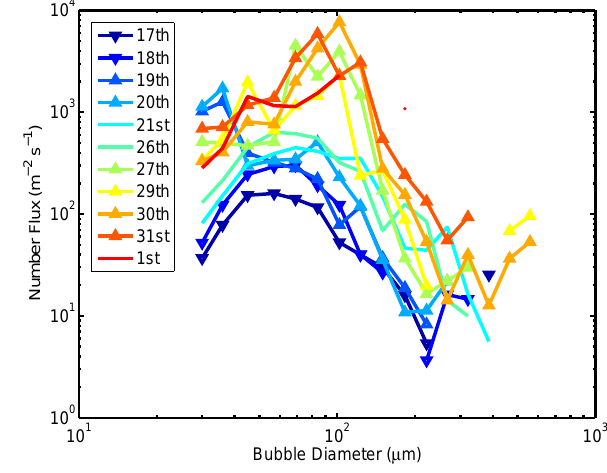
Fig. 12. The estimated total number flux of bubbles to the surface; symbols and colours are as in Fig. 9. Fig. 13. The mean size resolved bubble number fluxes to the sur- face. Symbols and colours are as in Fig. 9, but symbols are plotted only for those days where the lead surface was not frozen